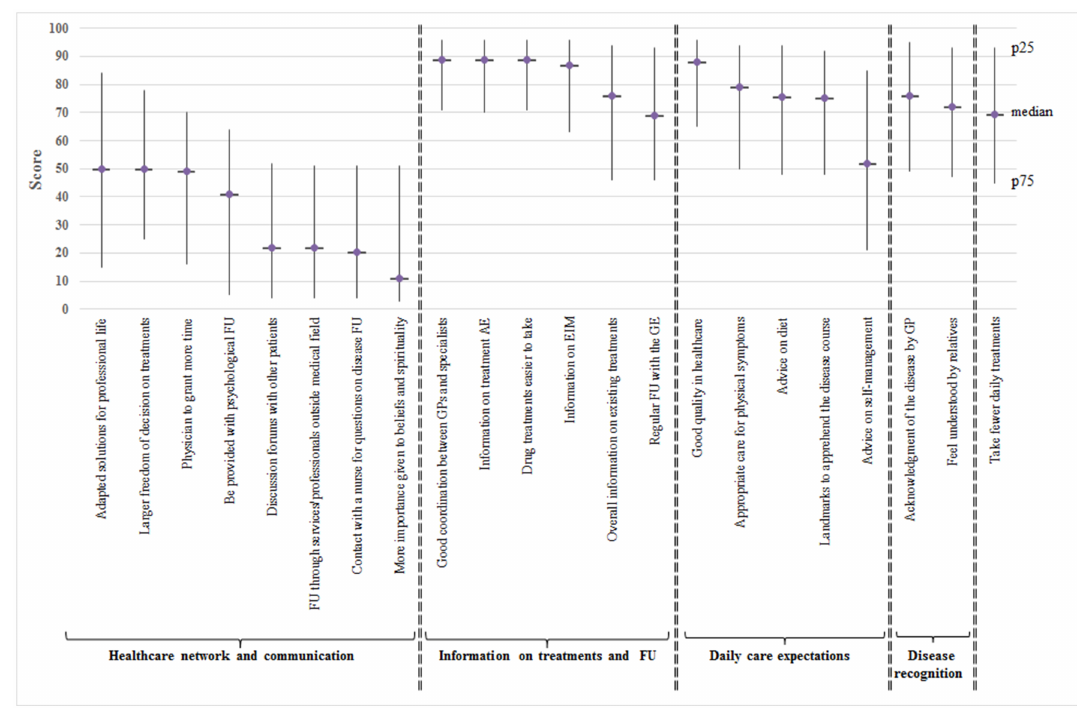
Fig 1. Comparison of median (interquartile range) scores for individual healthcare expectations in the SIBDC patient